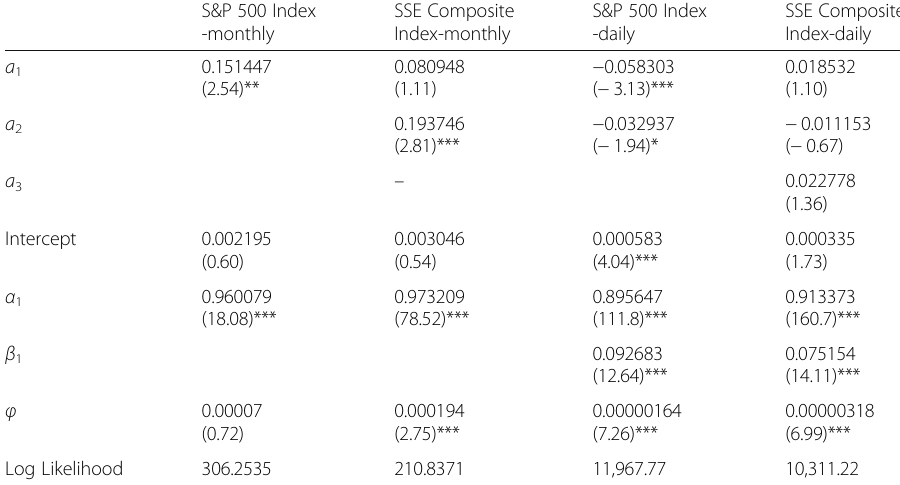
Table 6 Parameter estimates for the AR-GARCH process. The table reports the parameter estimates for the AR( p )-GARCH(1,1) processes for daily and AR( p )-GARCH (1,0) processes for monthly data. The notations come from expressions (2.2), (2.40) and (2.41). The numbers in parentheses are the t - ratios. The t -ratios marked with asterisks (double asterisks or three asterisks) indicate that the corresponding coefficients are statistically different from zero at 10% (5% or 1%) level